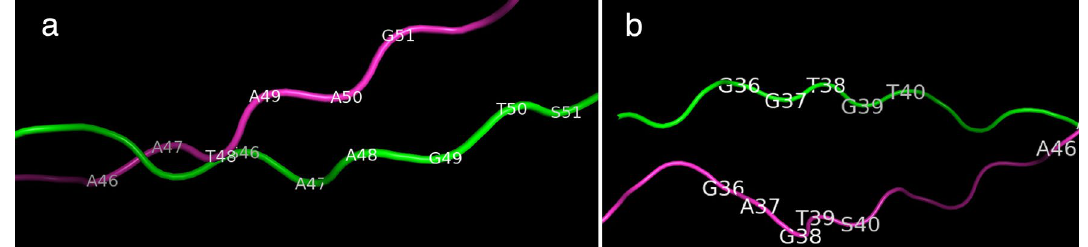
Figure 8. Variations in OsCENH3 (green) and Hθ (pink): ( a ) an extra triplet of TAA amino acids occurs from position 48–50 in Hθ, ( b ) Thr 38 is absent. Despite these facts, the helical structure is unaltered. The models were generated using Modeller 10.1 and superimposed using PyMOL version